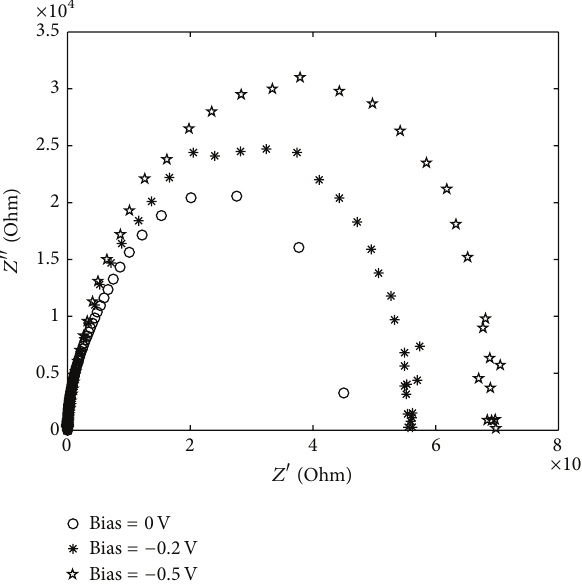
Figure 5: Impedance spectra of LCPV module under reverse bias conditions.